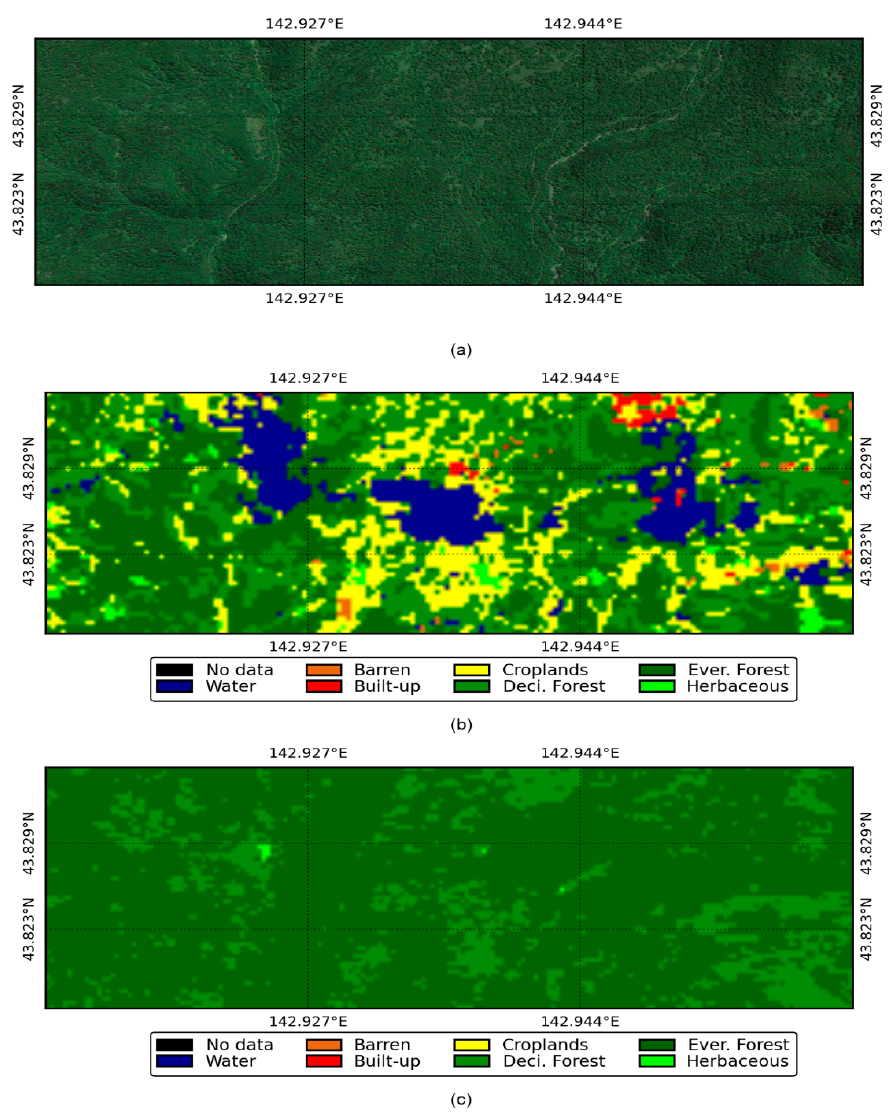
Figure 7. Performance of the JpLC-30 map over the JHR LULC map: ( a ) Google Earth™ image; ( b ) JHR LULC map; ( c ) JpLC-30 map.